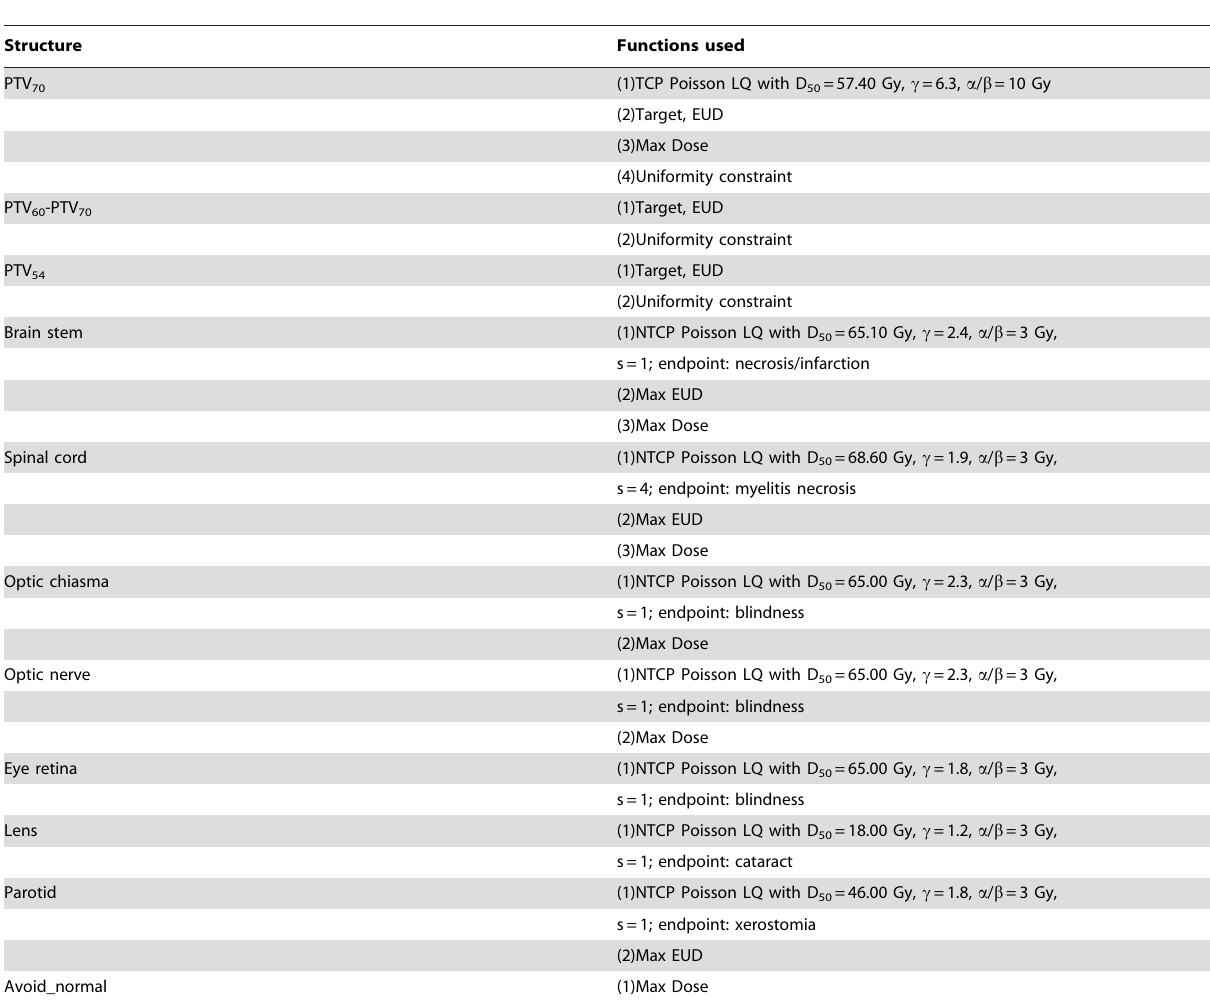
Table 3. The biological functions and additional constraints that are selected for optimization of the NPC patient plans.